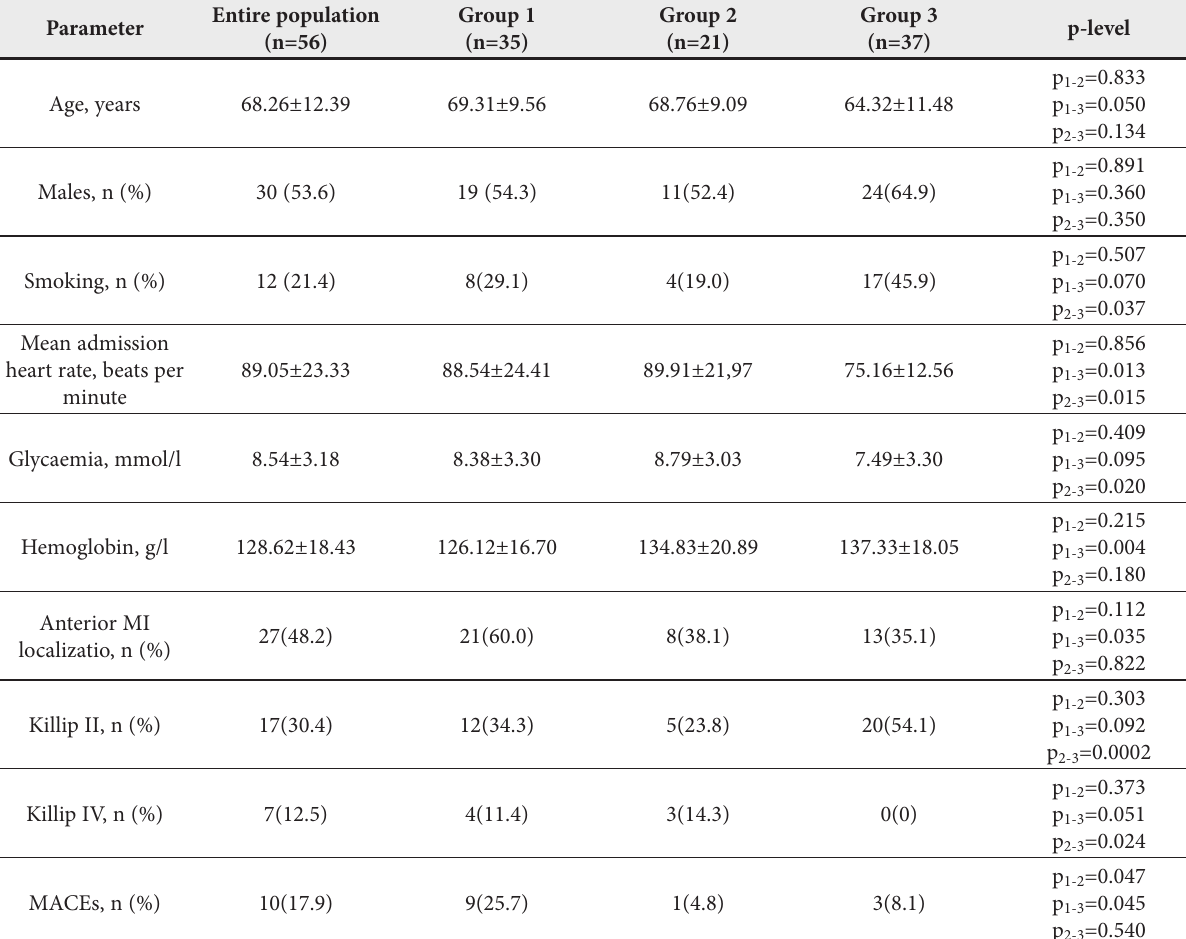
Clinical characteristics of examined